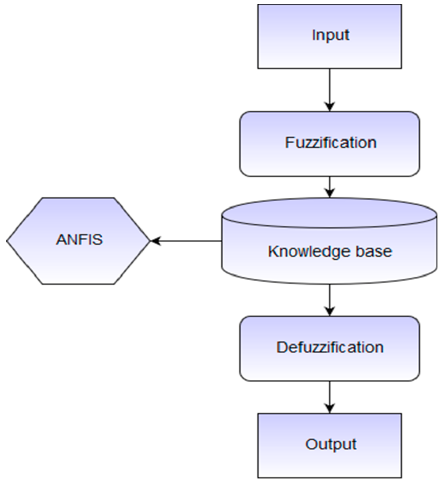
Figure 1. Typical Adaptive neuro-fuzzy Inference System (ANFIS) units.